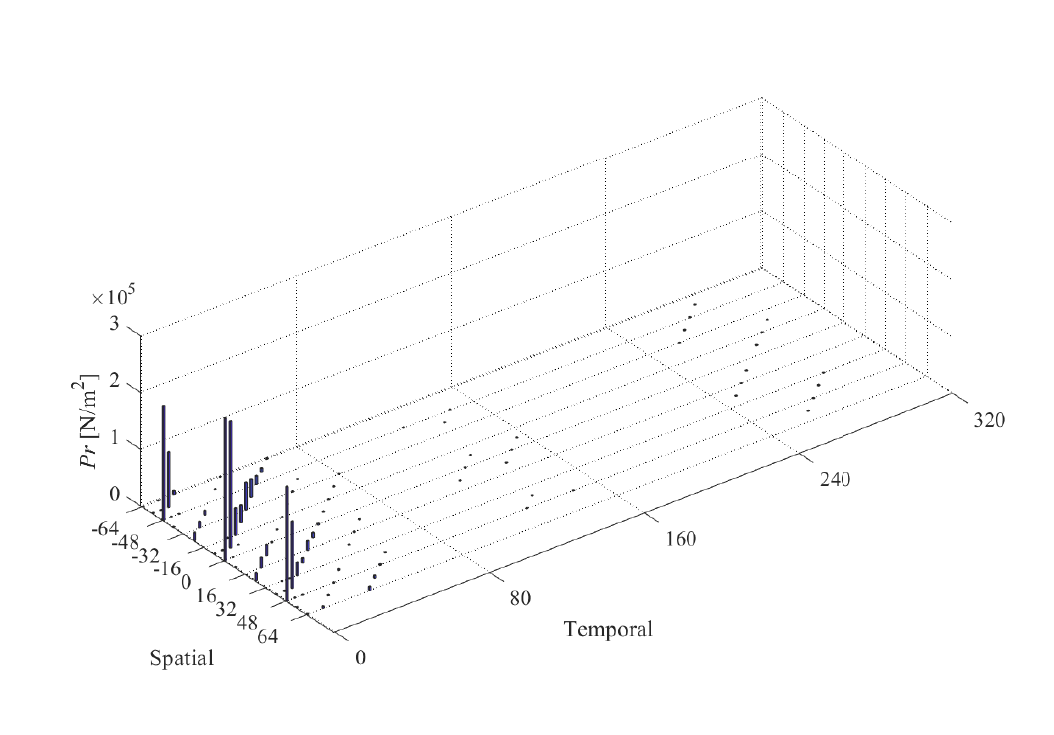
Figure 14. 2D FFT result of radial force in Model